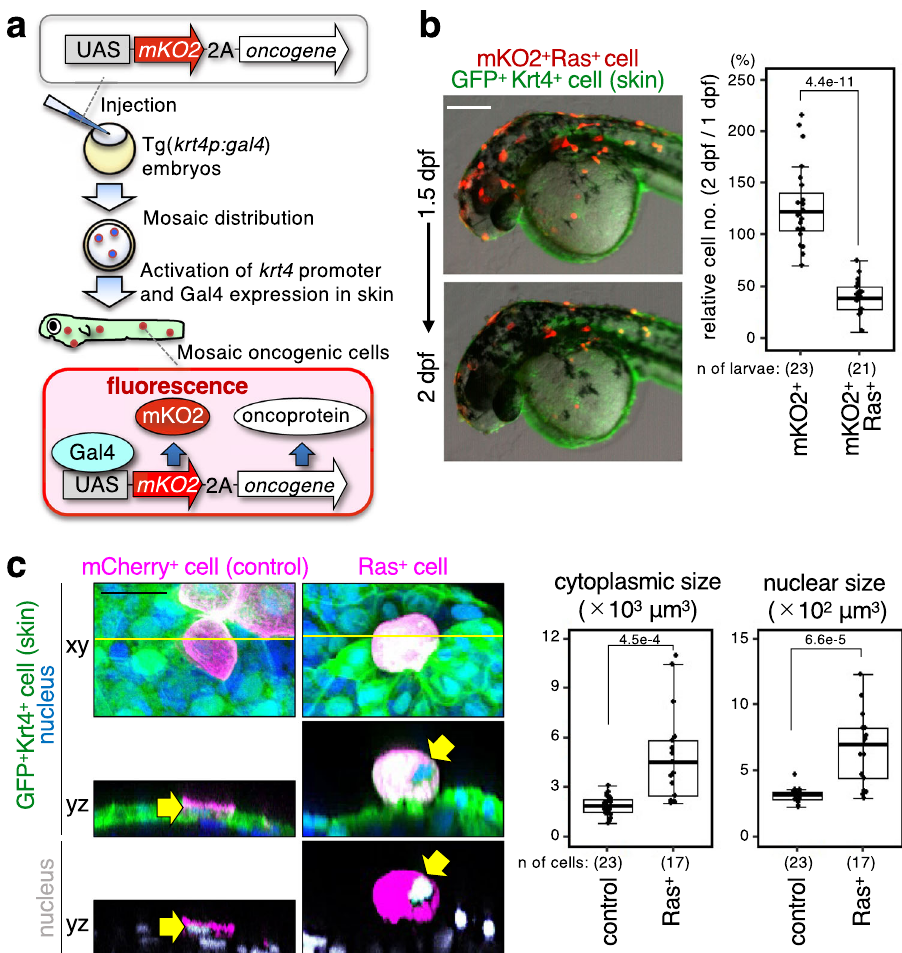
Fig. 1 Newly generated Ras G12V cell surrounded by normal cells is eliminated from zebra fi sh epithelia. a Schematic illustration of experimental introduction of fl uorescent oncogenic cells in zebra fi sh larval skin in a mosaic manner through the Gal4/UAS system. b Mosaic Ras G12V cell disappears from larval skin. Representative images show the larvae with mosaically introduced cells expressing mKO2 with Ras G12V (mKO2 + Ras + cells) (red). Skin cells were visualised with krt4p:gal4; UAS:EGFP (green). Scale bar: 200 μ m. Bottom box plots of relative mKO2 + cell number of 2 days postfertilisation (dpf)/1 dpf ratio show fi rst and third quartile, median is represented by a line, whiskers indicate the minimum and maximum, and outliers are shown as dots outside of the box. Each dot represents one larva. Unpaired two-tailed t-test was used. Note that oncogenic cells were introduced not only to the head region but also to the trunk and tail regions, and their disappearance occurred in all areas. c Cytoplasmic and nuclear swelling occurs in mosaic Ras G12V cells. Representative confocal images show mosaic mCherry + (control) or mCherry + Ras G12V (Ras + ) cells (magenta) and nucleus (upper; blue, lower; grey) in the larvae. Arrows indicates nuclei of mCherry + cells. Scale bar: 20 μ m. Box plots of estimated nuclear or cytoplasmic size ( μ m 3 ) show fi rst and third quartile, median is represented by a line, whiskers indicate the minimum and maximum, and outliers are shown as dots outside of the box. Each dot represents one cell. Unpaired two-tailed t -test was used. Source data are provided as a Source Data fi